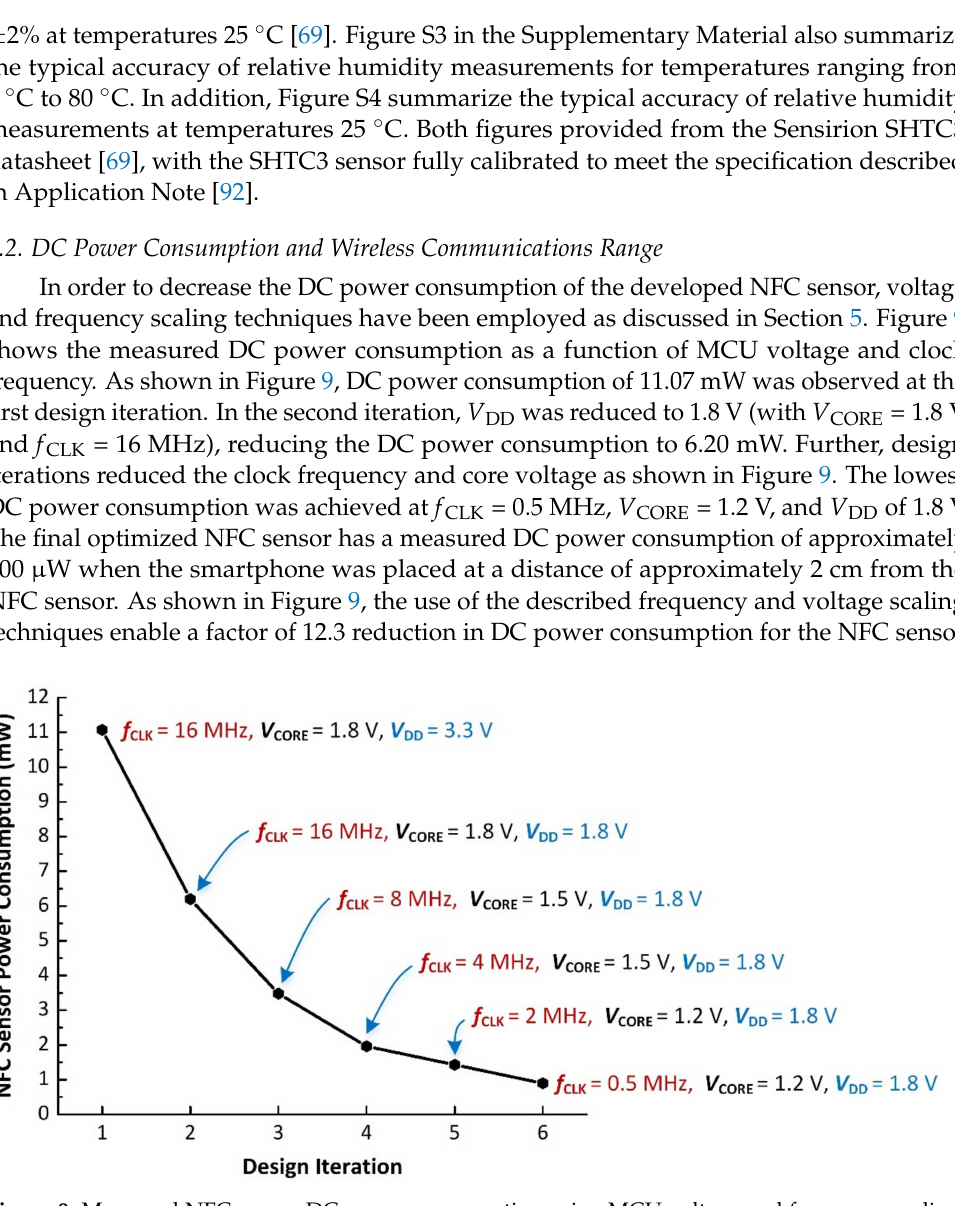
Figure 9. Measured NFC sensor DC power consumption using MCU voltage and frequency